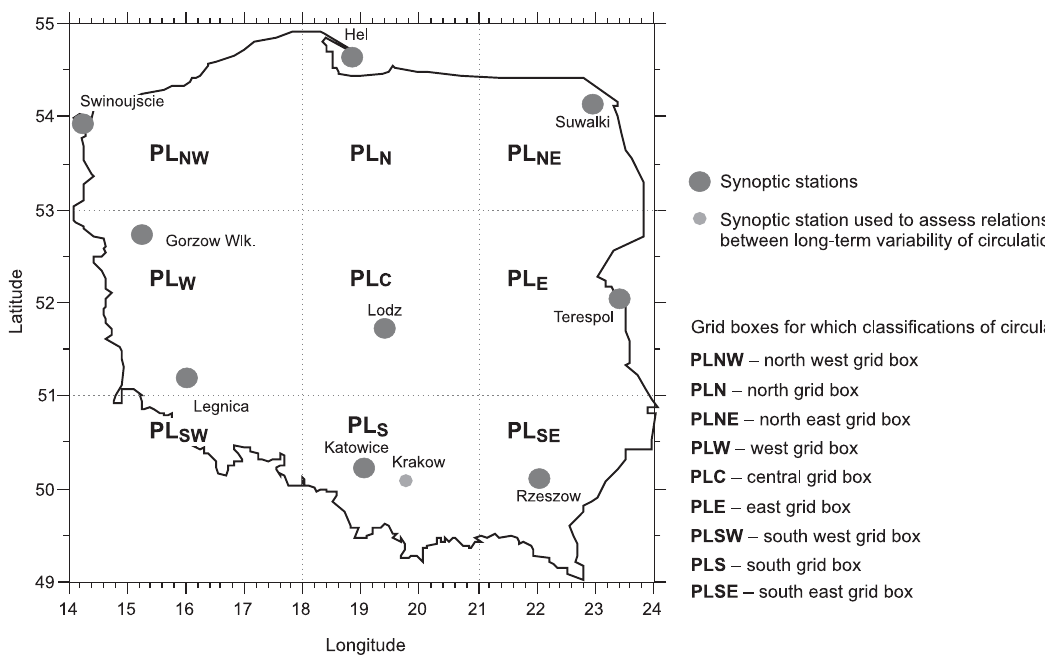
Fig. 1. Location of meteorological stations and grid boxes for which the classifications of circulation types